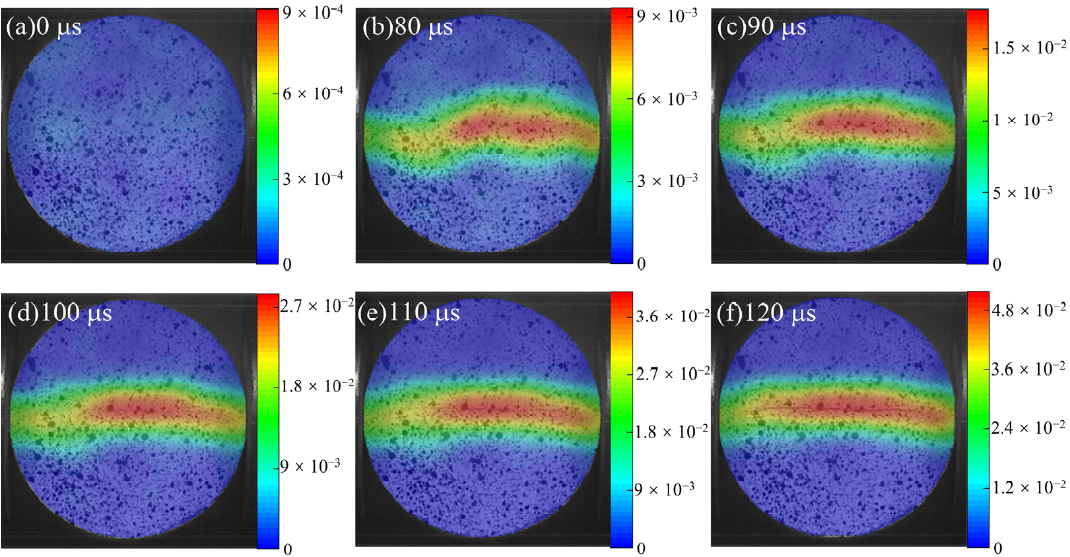
Figure 6. Full-field strain of the Breccia specimen at 4.86 m/s striking velocity: ( a ) 0 µ s; ( b ) 80 µ s; ( c ) 90 µ s; ( d ) 100 µ s; ( e ) 110 µ s; ( f ) 120 µ s.